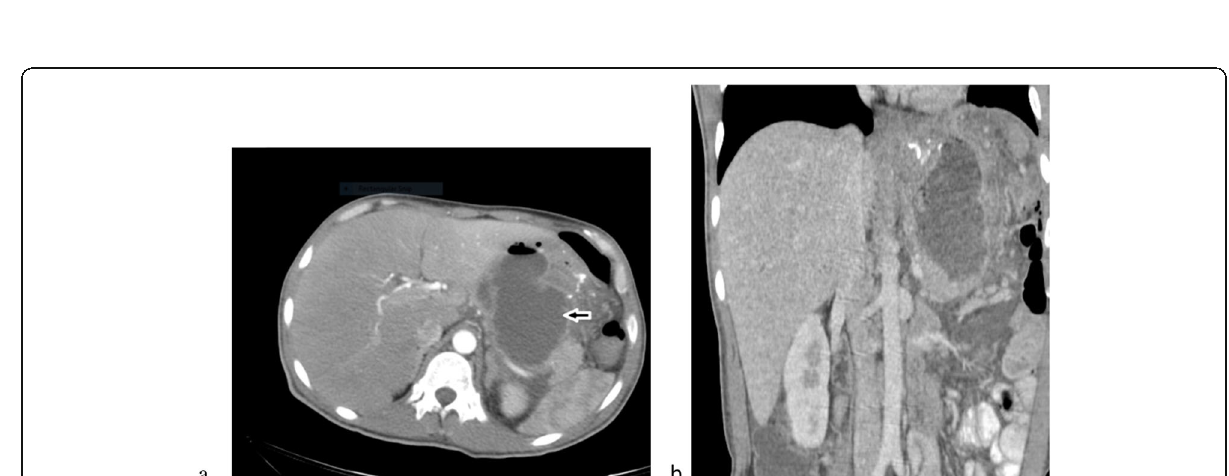
Fig. 1 A thirty-five-year-old male patient presented 5 days post-Roux-en-Y gastric bypass by abdominal pain and fever. a MSCT axial and b coronal reconstruction images show thick-walled marginally enhancing fluid collection with increased density of the surrounding mesenteric fat planes. MSCT diagnosis, operative bed-infected